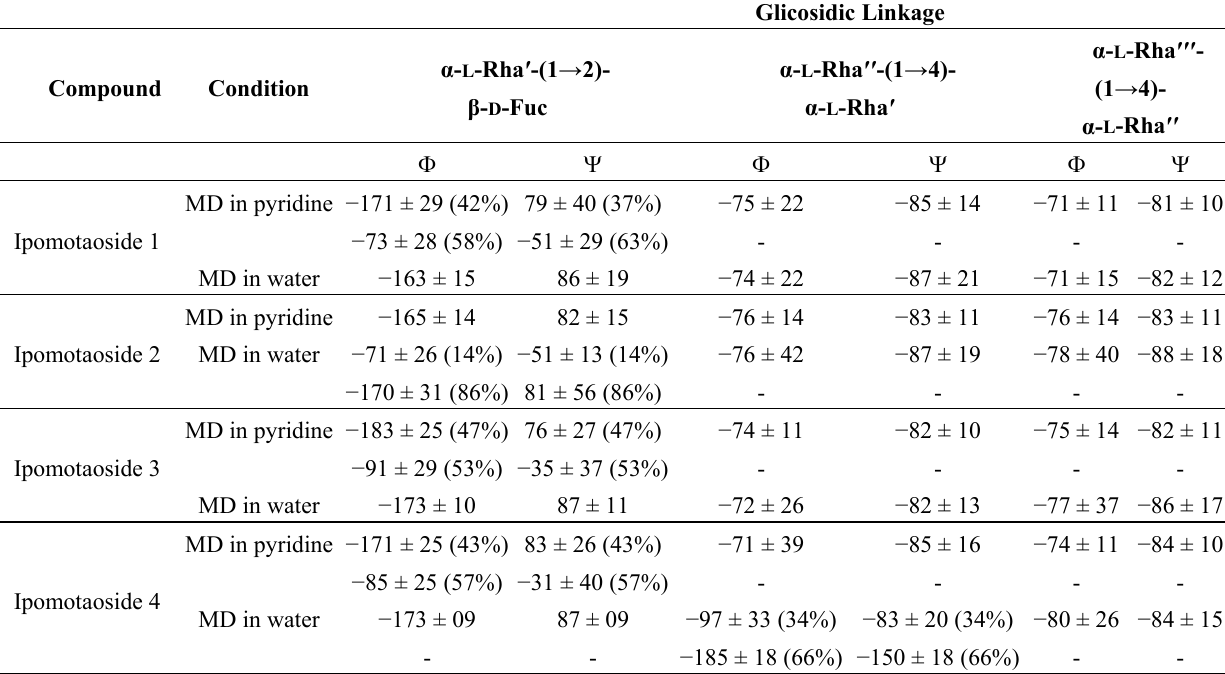
Table 1. Dihedral angles from Ipomotaosides glycosidase linkages, as obtained from MD.